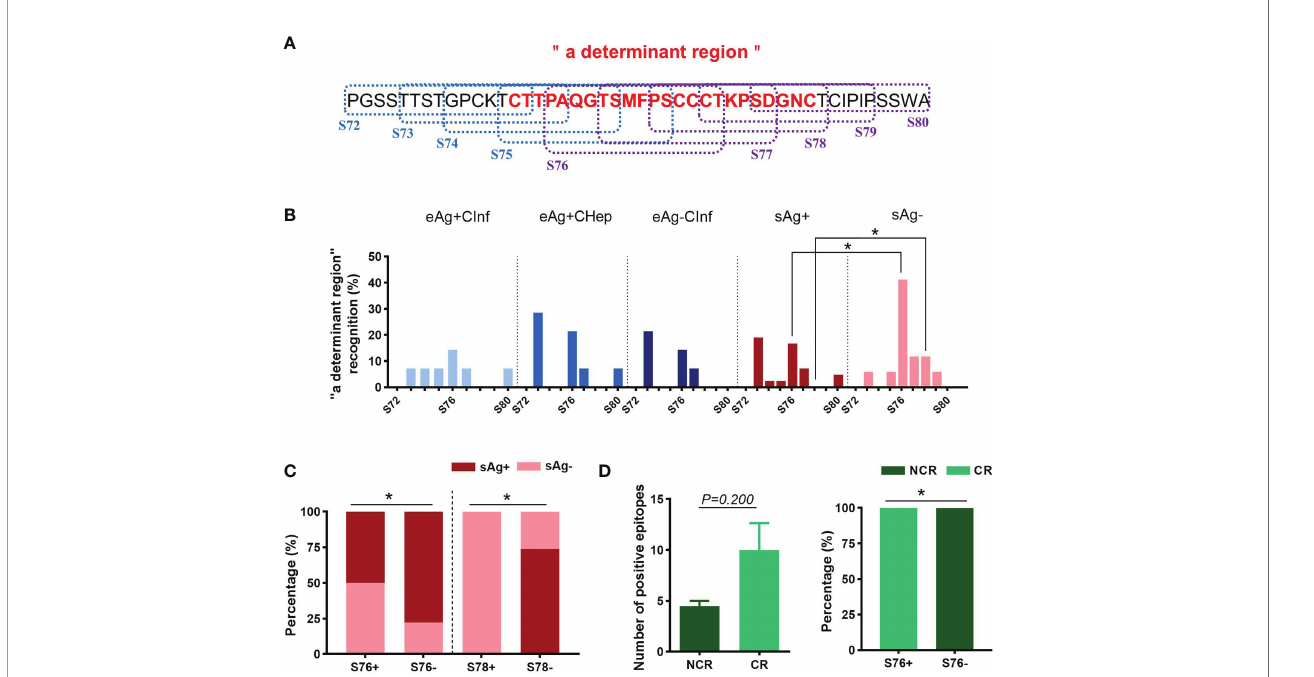
FIGURE 4 | Distribution of linear B-cell epitopes on “ a determinant region ” . (A) The amino acid sequence of “ a determinant region ” . The dotted boxes indicate the corresponding peptides. The “ a determinant region ” was in red. (B) The recognition rate of each peptide in “ a determinant region ” . (C) The proportion of patients with detectable sAg or sAg loss in the S76+/- or S78+/- groups. (D) Comparison of the number of positive peptides between the complete response (CR) and noncomplete response (NCR) groups (left). The proportion of patients with different treatment responses in the S76+/- group (right). (B – D) Chi-square test. * P < 0.05.